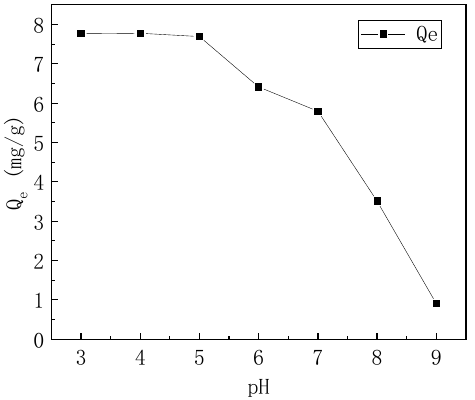
Figure 3. Graph of removal quantity as pH changes.